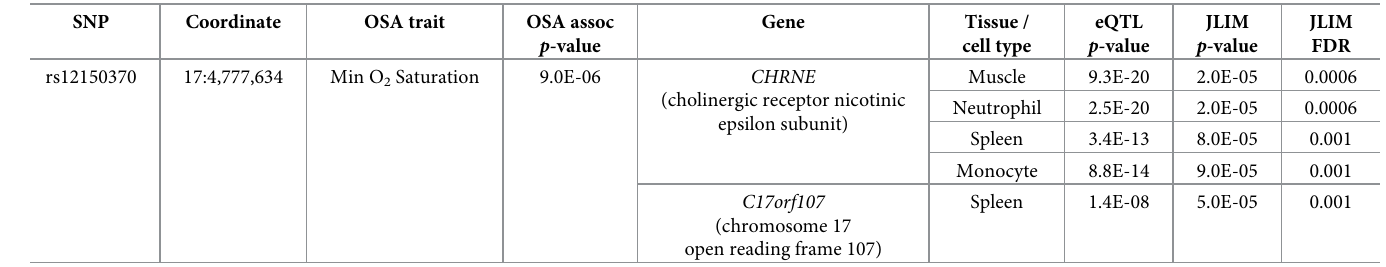
Table 3. Genome-wide significant loci in OSA traits colocalizing with eQTL.